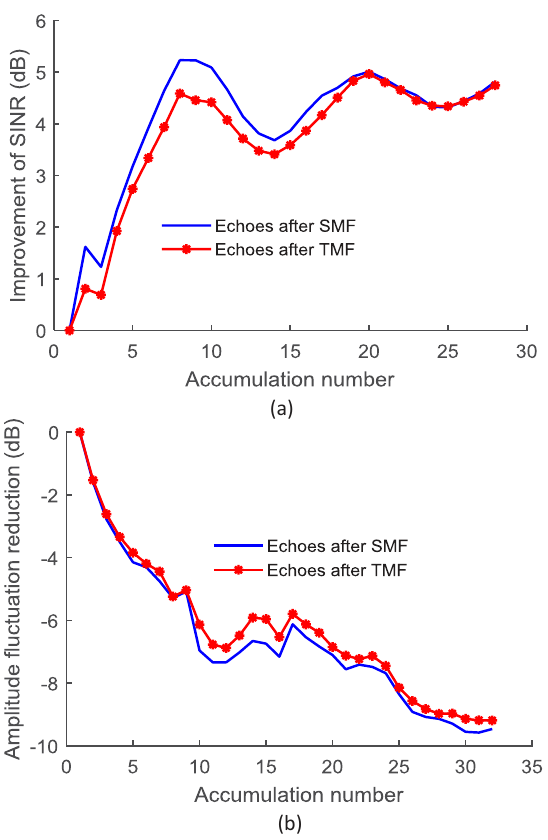
Figure 2. The performance of the ACA (Amplitude Coherence Accumulation) method for the echoes after processed by SMF (Self-adaption Matched Filter) and TMF (Traditional Matched Filter) , average result from 32 tests. ( a ) The SINR improvements with the accumulation number; ( b ) The amplitude fluctuation reduction of the noise/interference with the accumulation number. The frequency modulation rate of the LFM (Linear Frequency Modulation) signal is β = 6.35 × 10 13 , the bandwidth is BW = 60 MHz, the sampling rate is 184.32 MHz, the frequency center is 1.83 GHz and the pulse repetition rate is 600 Hz. The pulse duration time is about 0.945 µ s, i.e., 174 sampling